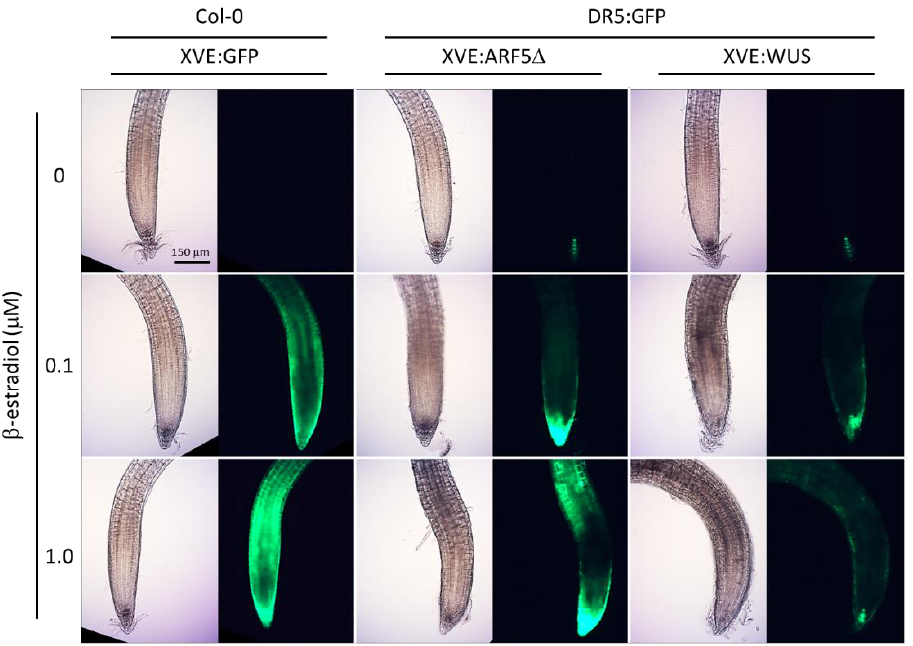
Figure 1. Ectopic overexpression of WUS or ARF5 Δ induces DR5:GFP in root tips. One-week-old seedlings were transferred to plates with varying amounts of β -estradiol and imaged in brightfield and GFP fluorescence after 24 h. Wild-type (Col-0) plants were transformed with XVE:GFP (left panel). Plants carrying DR5:GFP were transformed with XVE:ARF5 Δ and XVE:WUS (center and right panels, respectively). The scale bar represents 150 µm.